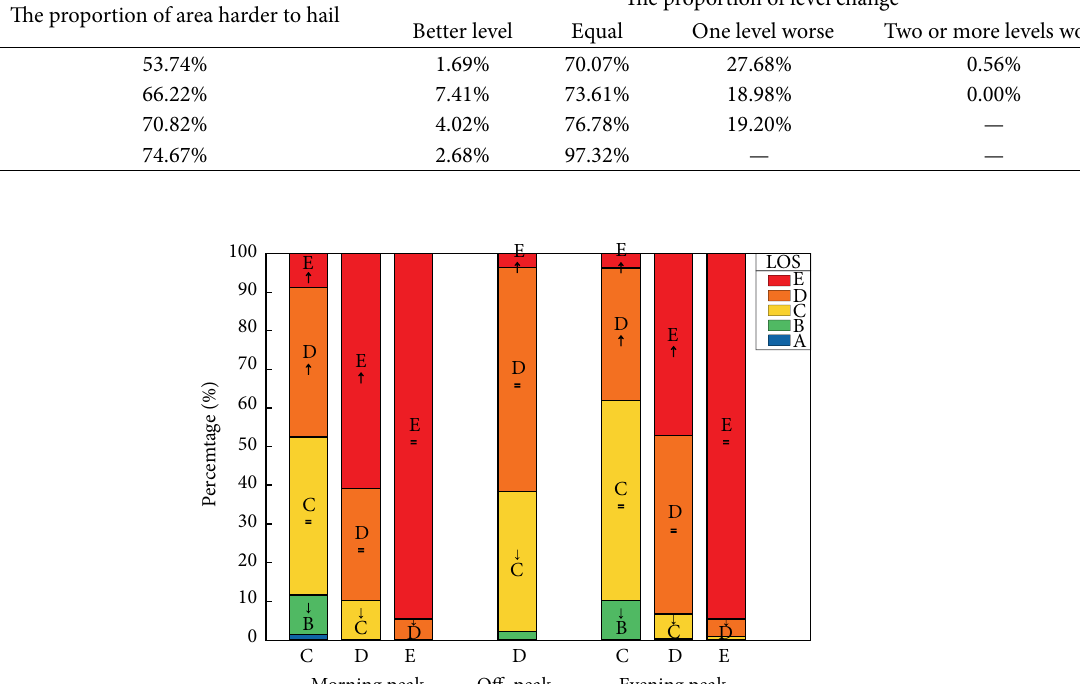
Table 3: The proportion of area and level change in regions with TLOS B, C, D, and E. TLOS The proportion of area harder to hail